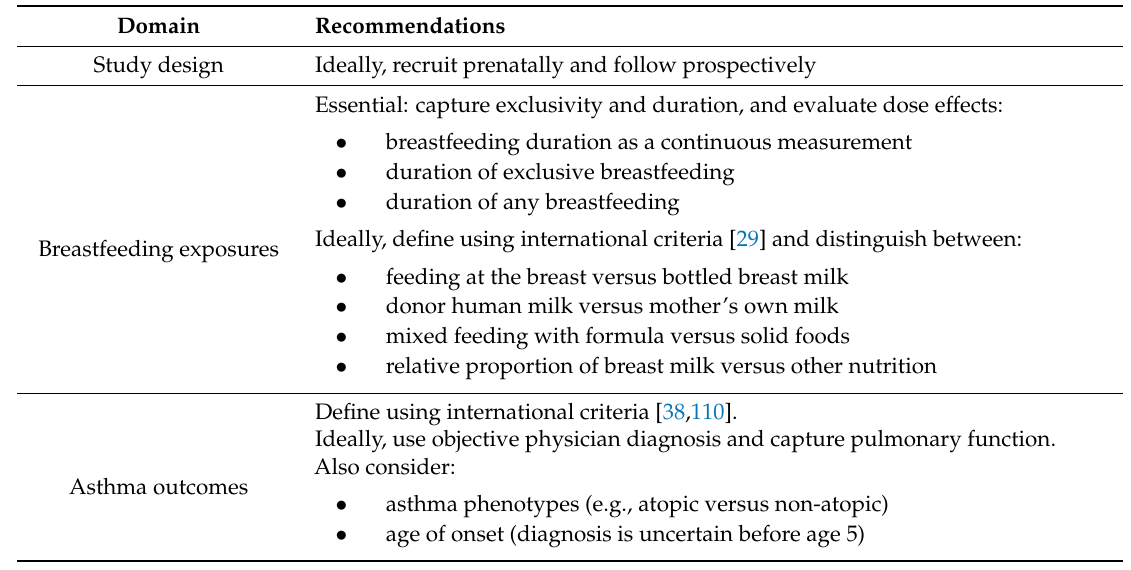
Table 1. Recommendations for future research on breastfeeding and asthma in new studies or using existing